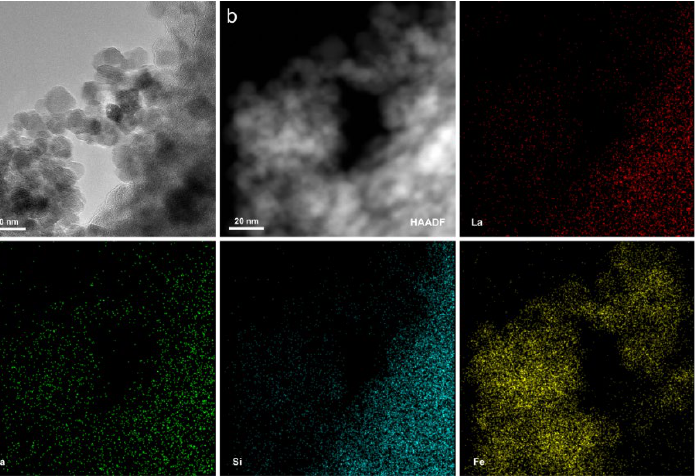
Figure 3. ( a ) TEM image of MALS-B; ( b ) HAADF-STEM image and corresponding elemental mapping distribution of MALS-B.